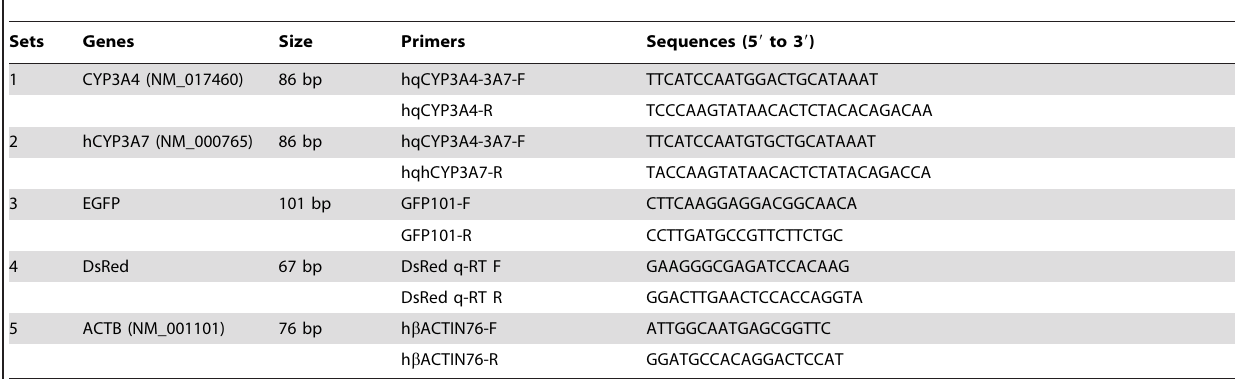
Table 3. PCR primers used for gene expression analyses.